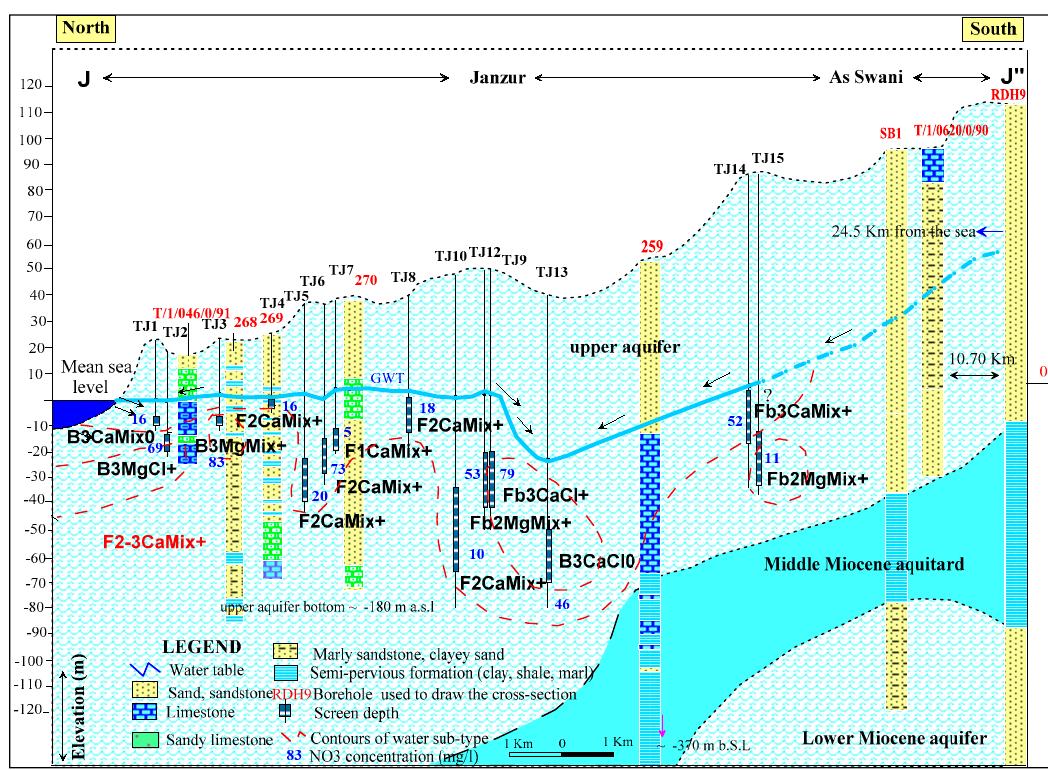
Figure 8. Hydrochemical profile in Tripoli (location of cross-section is indicated in Figure 2).